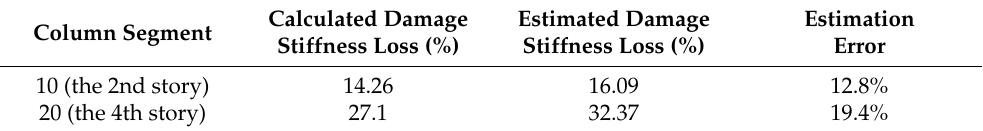
Table 4. Results of the damage